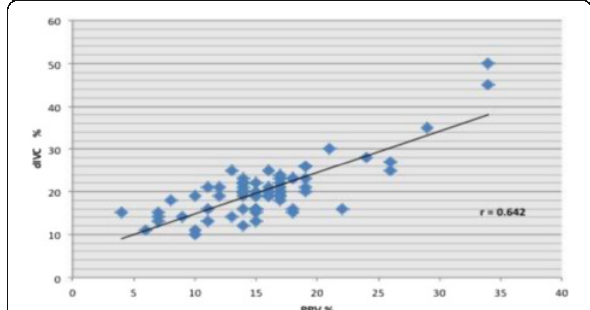
Fig. 73 (abstract A162). Correlation between distensibility index of inferior vena cava and pulse pressure